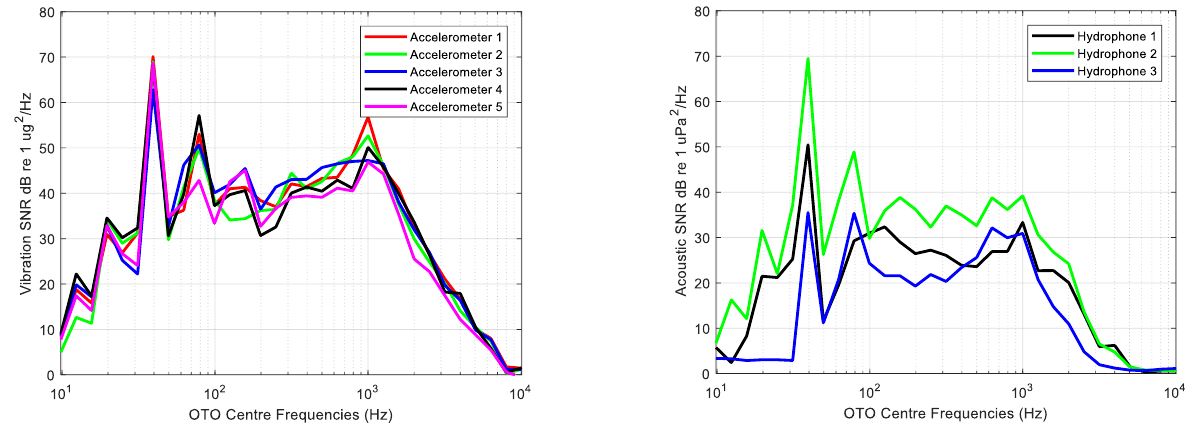
Figure 8. Signal to Noise Ratio ( SNR dB ) computed for the average of each one third octave band of vibration ( left ) and acoustic ( right ) measurements.